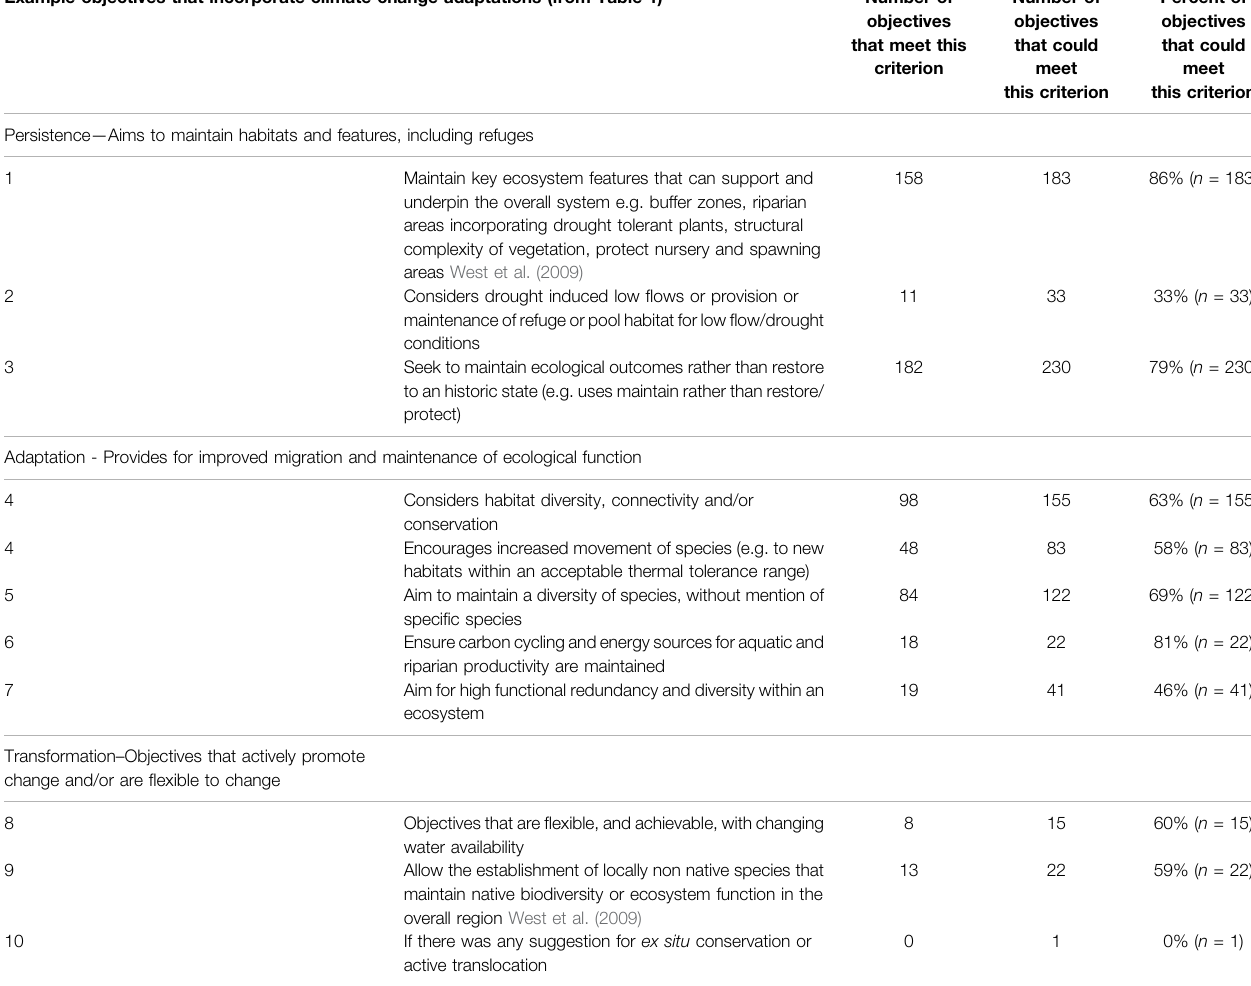
TABLE 2 | Assessment results comparing existing environmental fl ow planning documents against the climate change adaptation objectives of Table 1 (See Supplementary Material for more detail). Example objectives that incorporate climate change adaptations (from Table